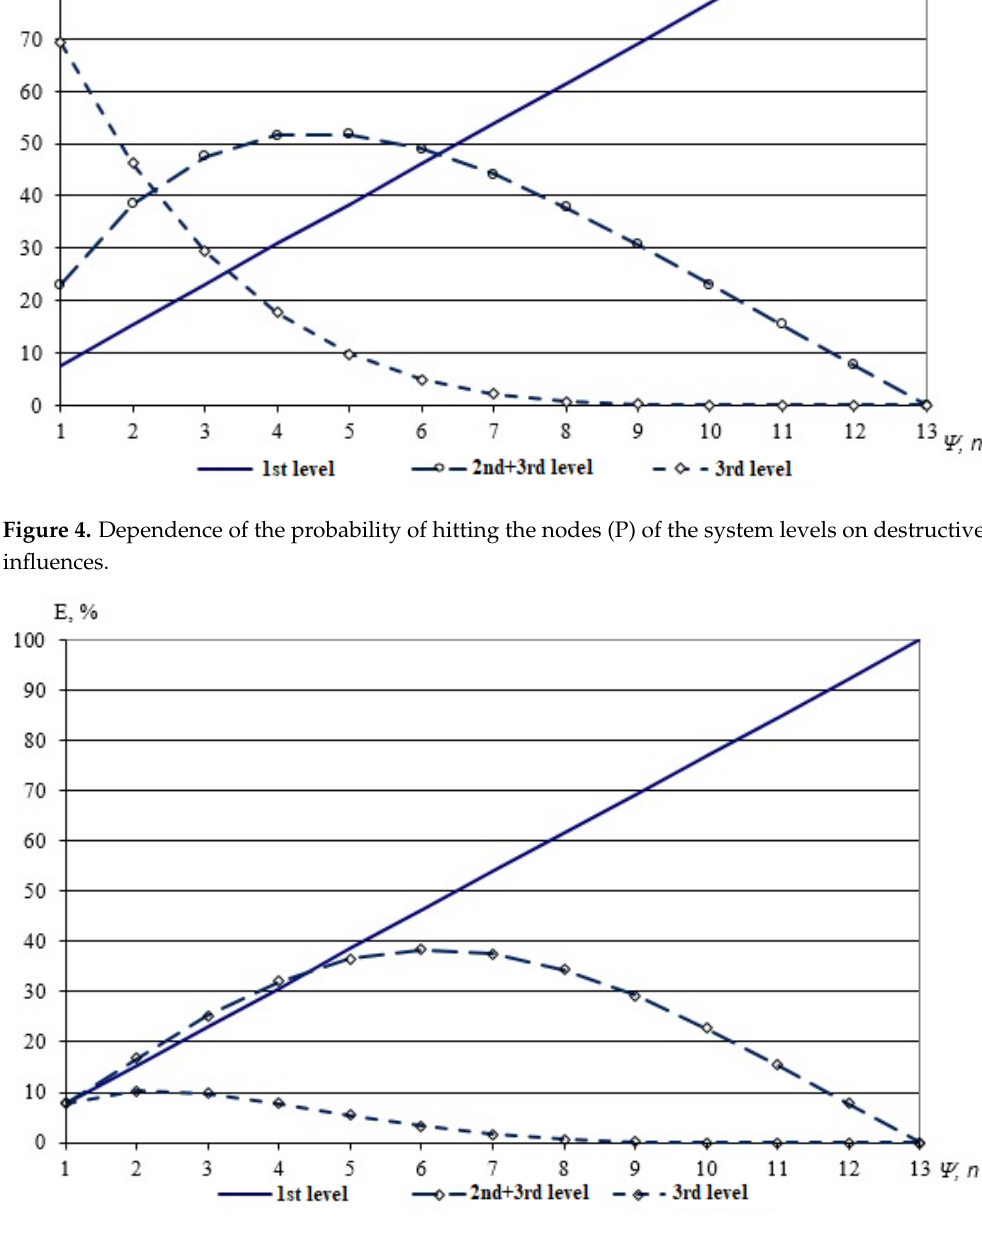
Figure 5. Dependence of information loss (E) by system levels on destructive